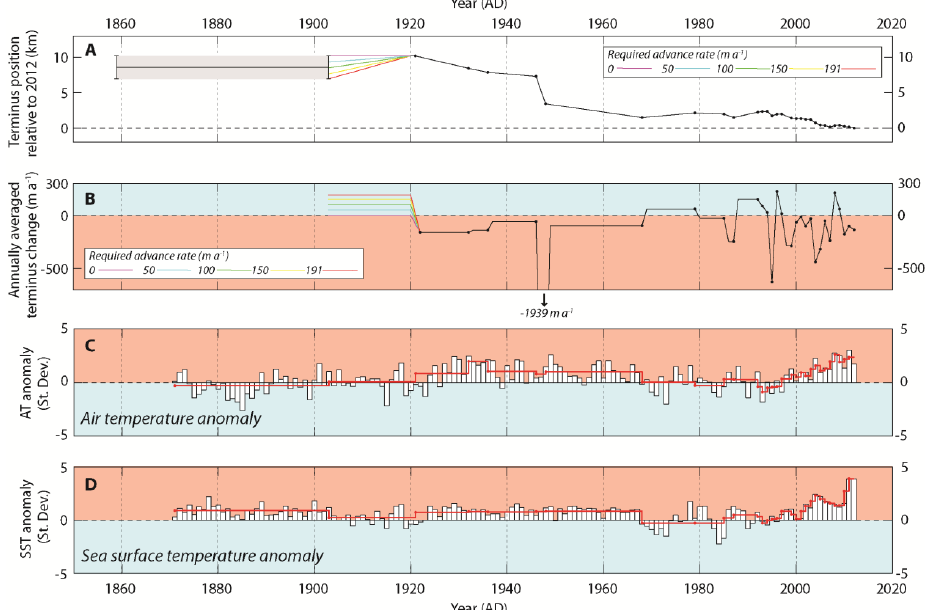
Figure 4. (a) Terminus change relative to the 2012 terminus position. Uncertainty in terminus position for 1859–1903 highlighted in grey, Figure 4. (A) Terminus change relative to the 2012 terminus position. Uncertainty in 2 with a range of potential advance rates for 1903–1920 indicated. These range from a minimum of no change (0ma − 1 ) to a maximum terminus position for 1859-1903 highlighted in grey, with a range of potential 3 possible advance rate of 191ma − 1 . (b) Annually averaged rates of terminus change between observations (black dots). Includes terminus advance rates described for 1903–1921 terminus change indicated on A . (c) Summer AT anomaly (June-July-August) at annual resolution advance rates for 1903-1920 indicated. These range from a minimum of no change 4 (white bars), and red line showing the averaged AT anomaly between terminus observations (Cappelen et al., 2012; Vinther et al., 2006). (d) Annual SST anomaly for the area 61 to 6 ◦ N, 51 to 56 ◦ W at annual resolution (white bars) with red line showing the averaged SST (0 m a -1 ) to a maximum possible advance rate of 191 m a -1 . (B) Annually averaged 5 anomaly between terminus observations (Rayner et al., rates of terminus change between observations (black dots). Includes terminus 6 advance rates described for 1903-1921 terminus change indicated on A . (C) 7 Summer ATA (June, July, August) at annual resolution (white bars), and red line 8 showing the averaged ATA between terminus observations (Cappelen et al, 2012; 9 Vinther et al, 2006). (D) Annual SSTA for the area 61° to 65° N 51° to 56° W at 10 annual resolution (white bars) and red line showing the averaged SSTA between 11 terminus observations (Rayner et al, 2003). 12